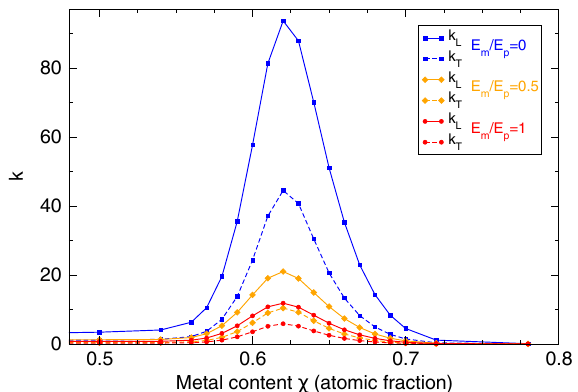
Figure 8. Longitudinal and transverse gauge factors for differ- ent elastic moduli of matrix ( E m ) and particles ( E p ). Blue: E m = 0 ,E p > 0. Orange: E m = E p / 2. Red: E m = E p .